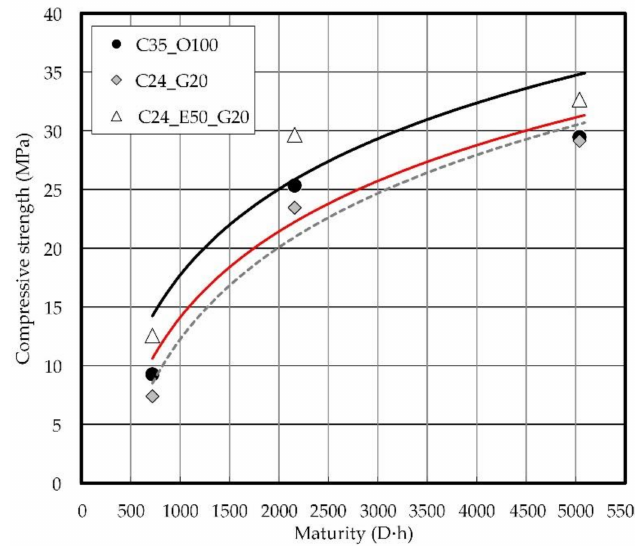
Figure 17. Relation between maturity and compressive strength on concrete.